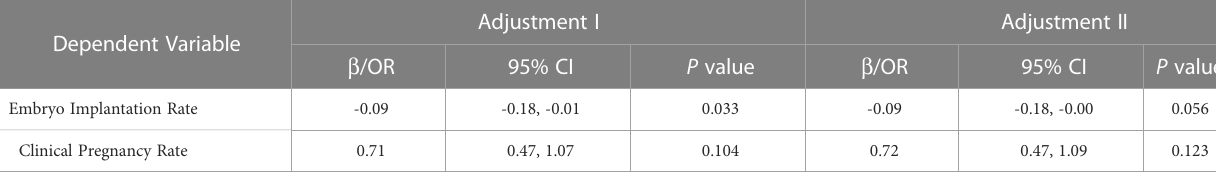
TABLE 5 Multivariate analysis for the effect of tamoxifen supplementation on the clinical outcome of total FET